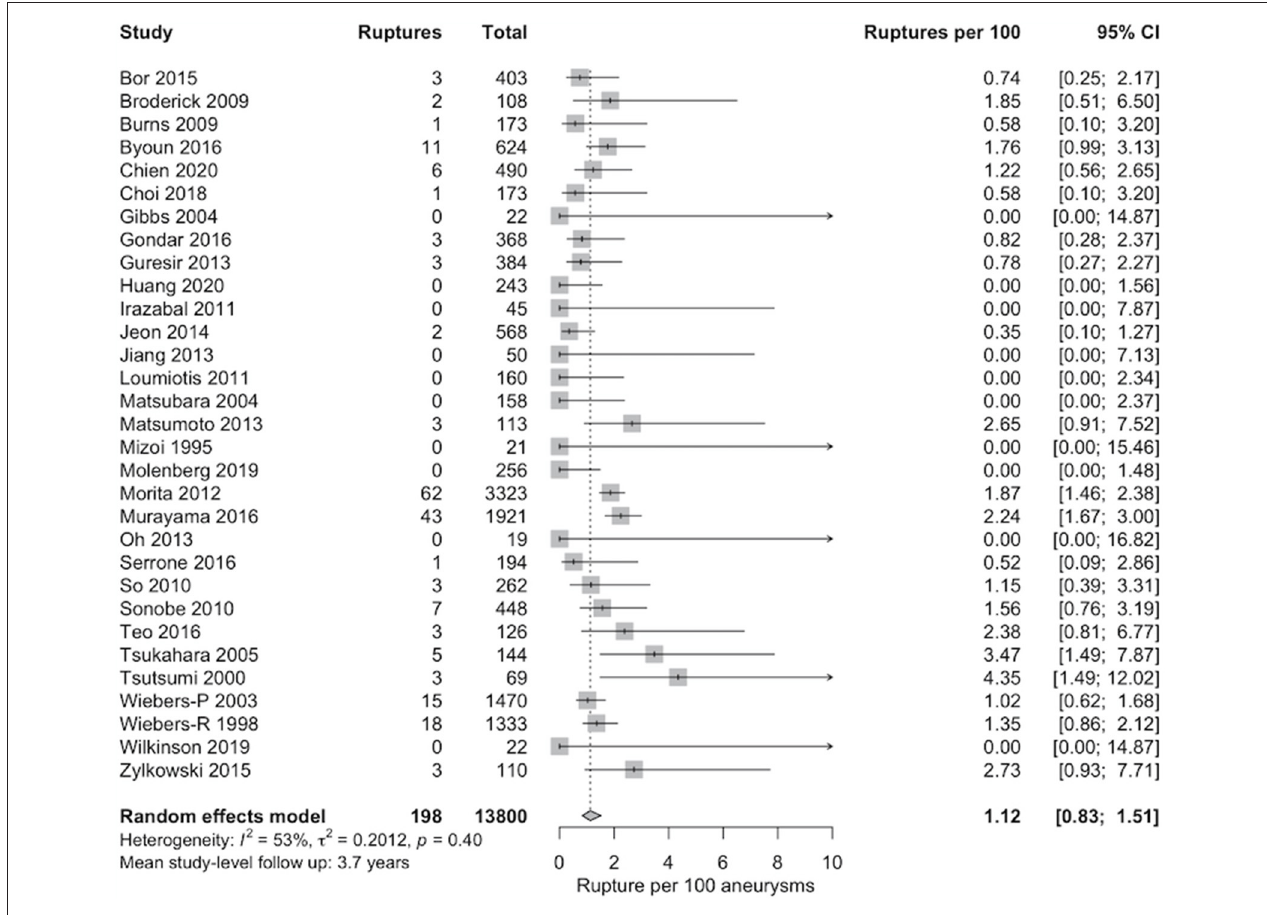
FIGURE 2 | Pooled proportion of rupture per 100 unruptured intracranial aneurysms (UIAs) ≤ 10mm managed without aneurysm repair. Random-effects data synthesis was carried out using a random intercept logistic regression model. The Wilson procedure was utilized for calculation of the 95%